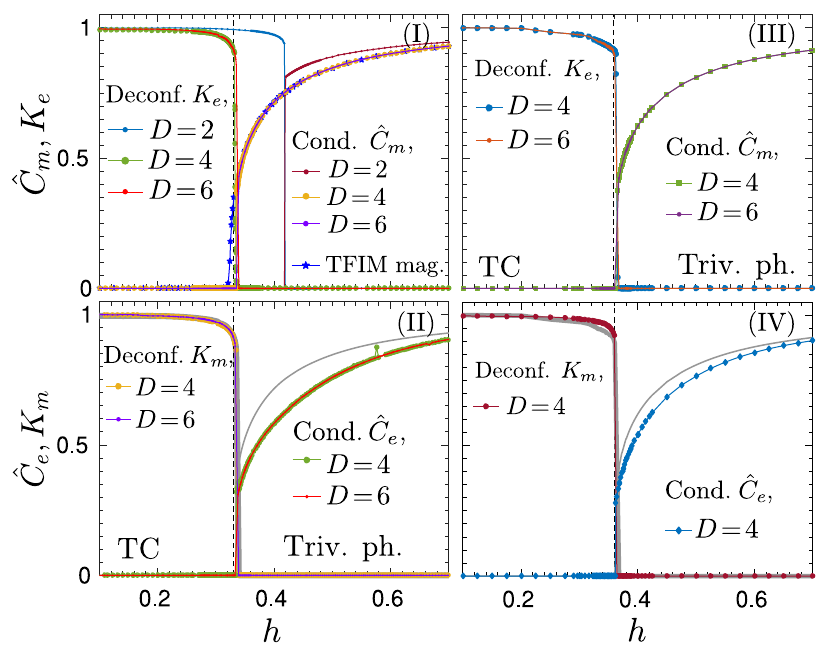
ˆ C FIG. 5. Order parameters for condensation and K for confinement across the four lines I – IV in Fig. 3, where along lines I and III a a magnetic fluxes a ¼ m condense and charges e confine, and vice versa for lines II and IV. Even though I and II, as well as III and IV, are dual to each other, the actual values of the order parameters are different due to the gauge degree of freedom in the construction of electric order parameters — for comparison, the D ¼ 6 data from the first row are indicated in gray in the dual panels below. Yet, their critical exponents are the same; see Figs. 6 and 7. We also observe that the magnetization of the transverse field Ising model equals along line I, as proven in Sec. III H.